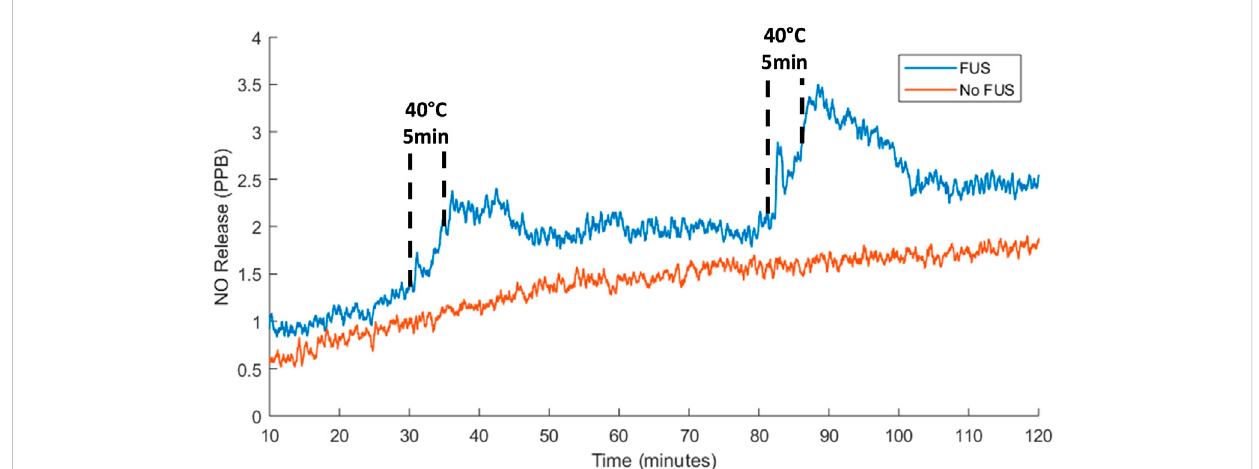
FIGURE 11 Instantaneous NO release from 4.8 mg SF hydrogels with no FUS stimulus and two 40 ° C FUS heating treatments where hydrogel warming was achieved with a peak acoustic pressure of 5.8 MPa and maintenance at 40 ° C for 5 min was obtained with a peak acoustic pressure of 3 MPa.